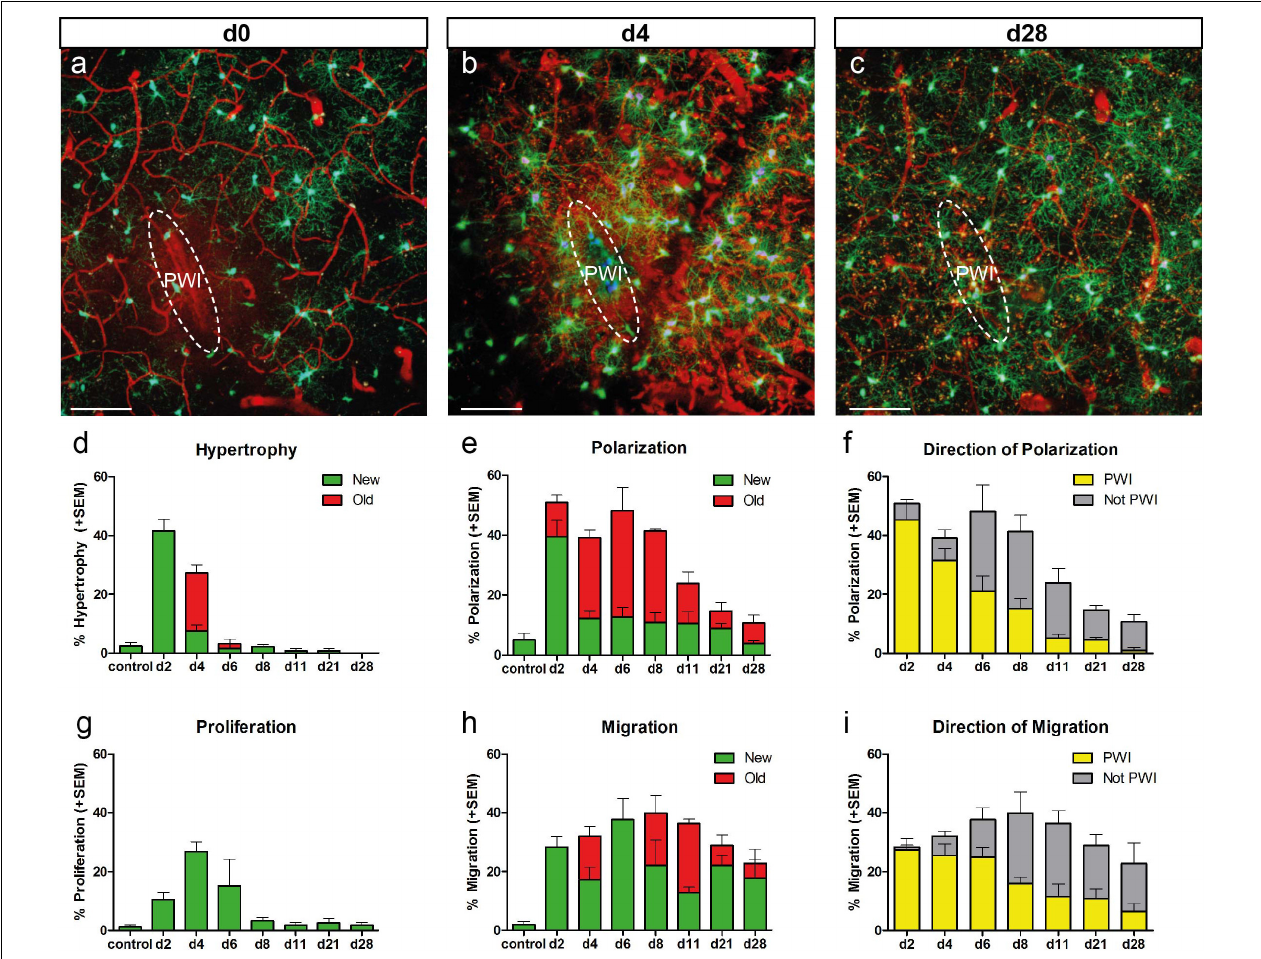
FIGURE 2 | Temporal reaction of NG2-glia after injury. (a–c) Images of NG2-glia around the injury site at d0 (a) , d4 (b) , and d28 (c) after PWI. (d,e,g,h) Graphs depict the percentage (mean + SEM) of cells showing hypertrophy, polarization, proliferation and migration at the given timepoints (n = 3 − 8 animals per timepoint). “New” (green bars) represent the cells showing hypertrophy (d) , polarization (e) , proliferation (g) and migration (h) for the first time at the indicated timepoint. “Old” (red bars) represent cells which showed this behavior already at the previous timepoint. (f,i) Directionality of polarized (f) or migrating (i) cells (mean + SEM; yellow bars represent the percentage of polarized cells with a direction towards the quadrant enclosing the PWI; grey bars represent percentage of polarized cells towards the remaining 3 quadrants) over time. n = 8 mice for timepoint d2, n = 6 mice for timepoint d4, n = 4 mice for timepoint d8, n = 3 mice for all other timepoints; mostly 20–30 cells per animal). Images show maximum intensity projections of 30 µ m deep stacks. Scale bars represent 100 µ m.